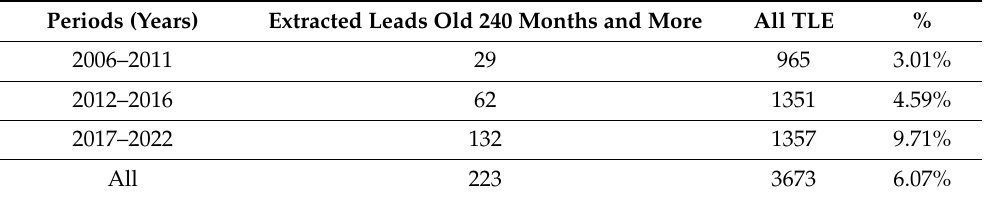
Table 1. Frequency of extraction of old leads (240 months and more) during following 5-years periods. Periods (Years) Extracted Leads Old 240 Months and More All TLE